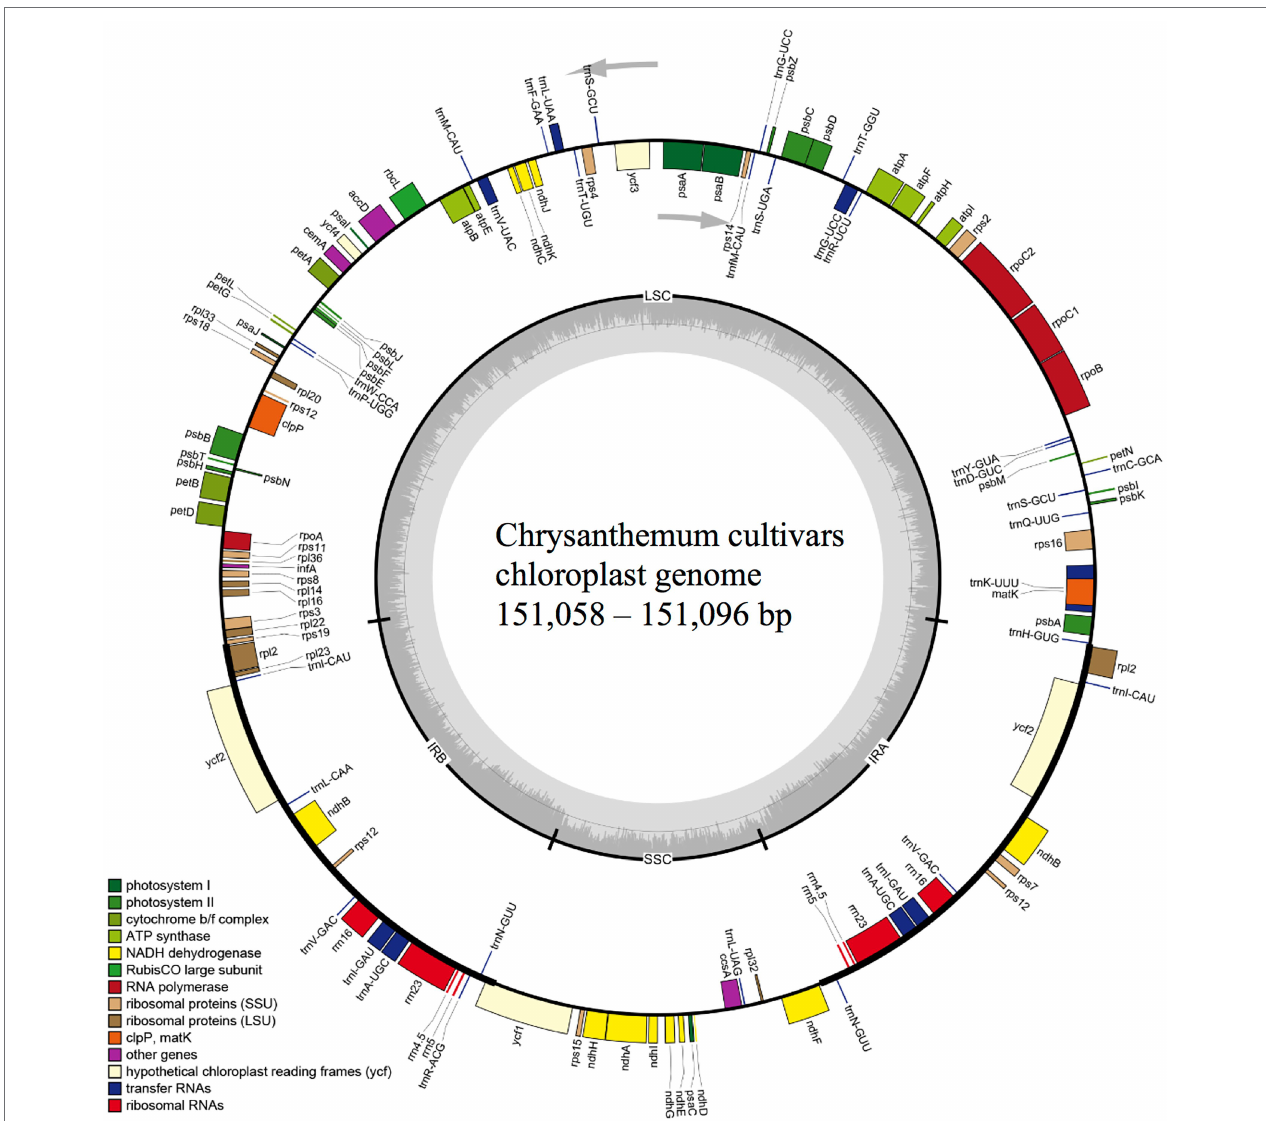
FIGURE 2 | Chloroplast genome map of 36 chrysanthemum cultivars. Genes transcribed clockwise and counter-clockwise are showed inside and outside the circle, respectively. Genes belonging to different functional groups are color-coded. Dark gray in the inner circle corresponds to GC content. LSC, large single copy region; SSC, small single copy region; IRA and IRB, inverted